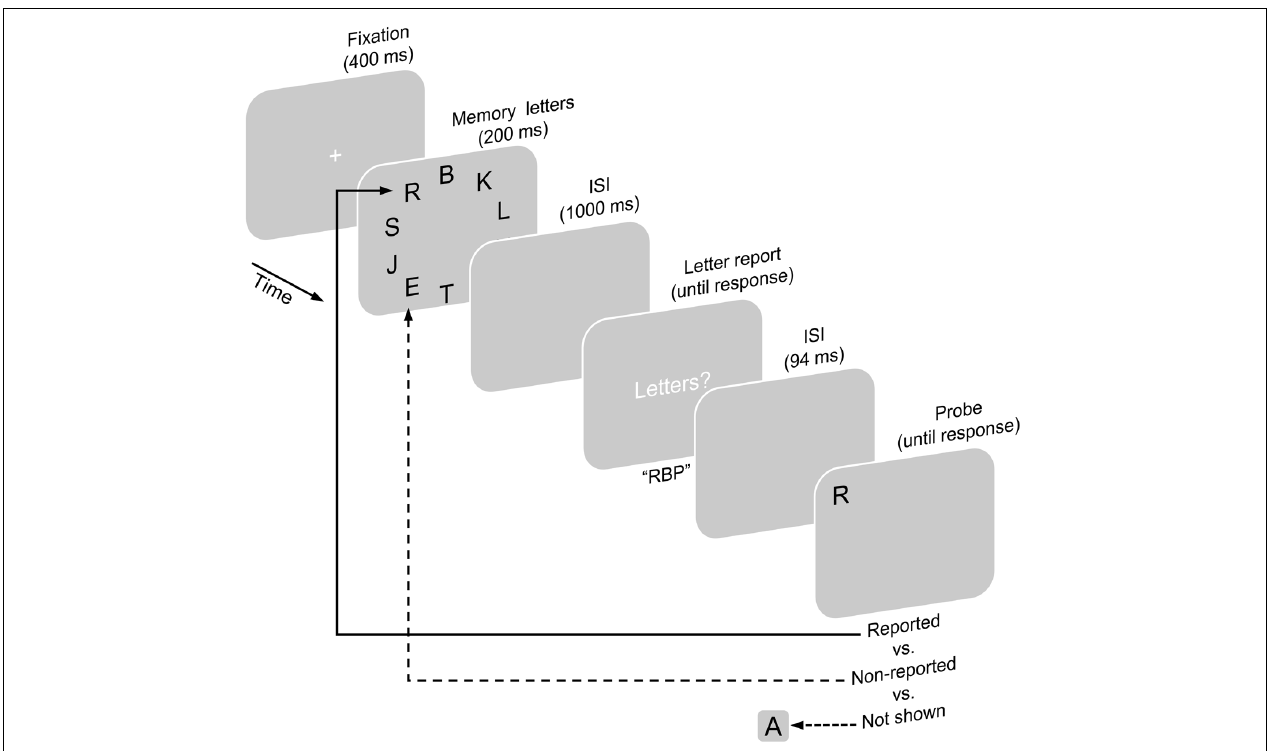
FIGURE 1 | Experimental paradigm of Experiment 1. On each trial, participants fixated a fixation cross after which 10 memory letters were shown. After an interstimulus interval (ISI), a response screen appeared (showing the text “Buchstaben?” instead of the here stated translation “Letters?”) and lasted until participants indicated that they finished reporting as many memory letters as they could (whole report task). After another ISI a single probe letter was presented. Participants then indicated whether or not the probe was one of the memory letters (probe recognition task). Probes have been either both, contained in the set of memory letters and reported (reported condition), or contained but not reported (non-reported condition), or they have not been contained (not shown